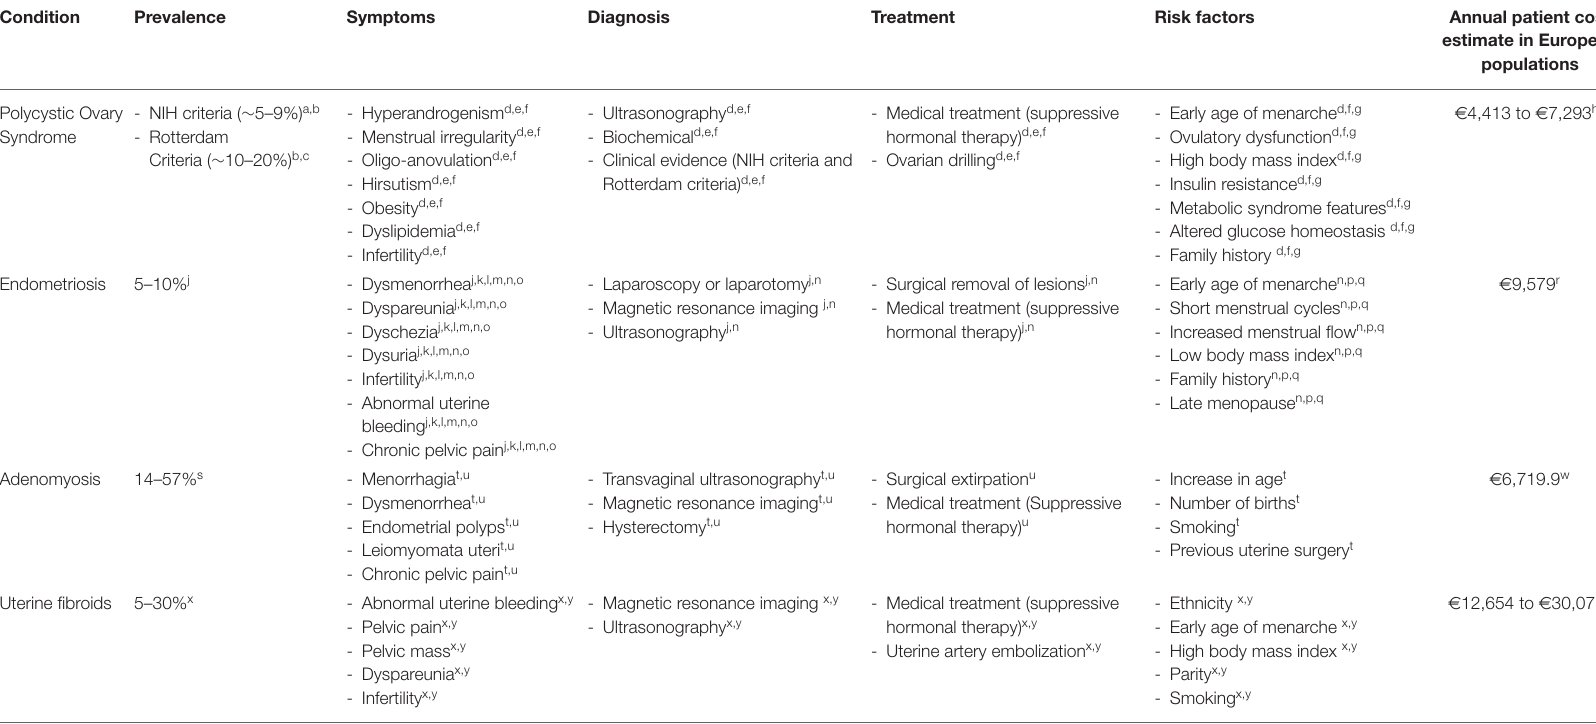
TABLE 1 | Prevalence estimates, symptoms, diagnostic criteria, treatment method, risk factors, and average annual cost estimate of PCOS, endometriosis, adenomyosis, and uterine fibroids.